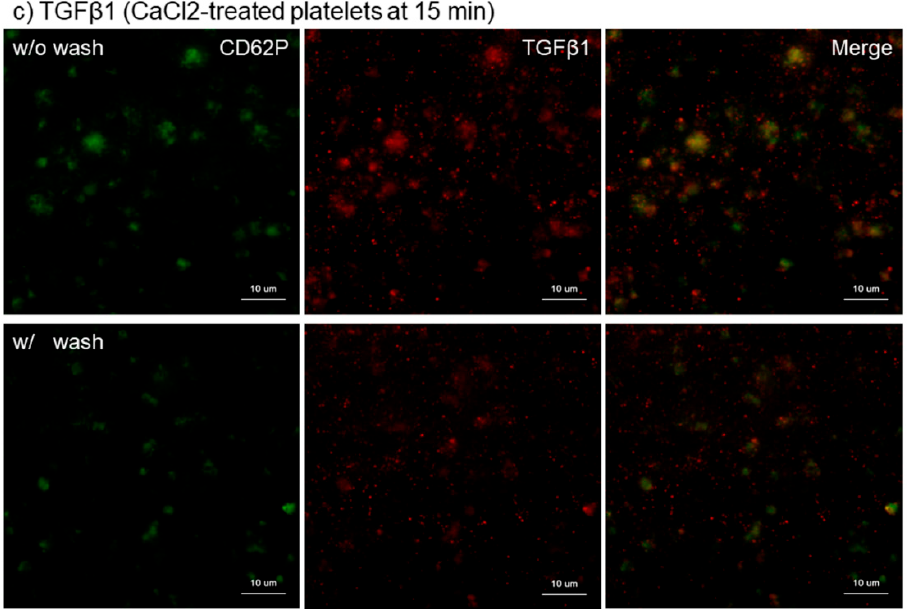
Figure 3. E ff ects of intensive washing on distribution of PPAR γ , PDGF-B, and TBG β 1 in Ca 2 + -activated platelets on cp -Ti plates. Platelets were treated with 0.1% CaCl 2 in PBS, incubated on cp -Ti plates for 15 min and fixed with ThromboFix with or without intensive washing. ( a – c ) Activated platelets (CD62P; green), ( a ) PPAR γ (red), ( b ) PDGF-B (red), and ( c ) TGF β 1 (red) were visualized by immunofluorescence. Similar findings were obtained from the samples prepared from the other three donors. Bar = 10 µ m.